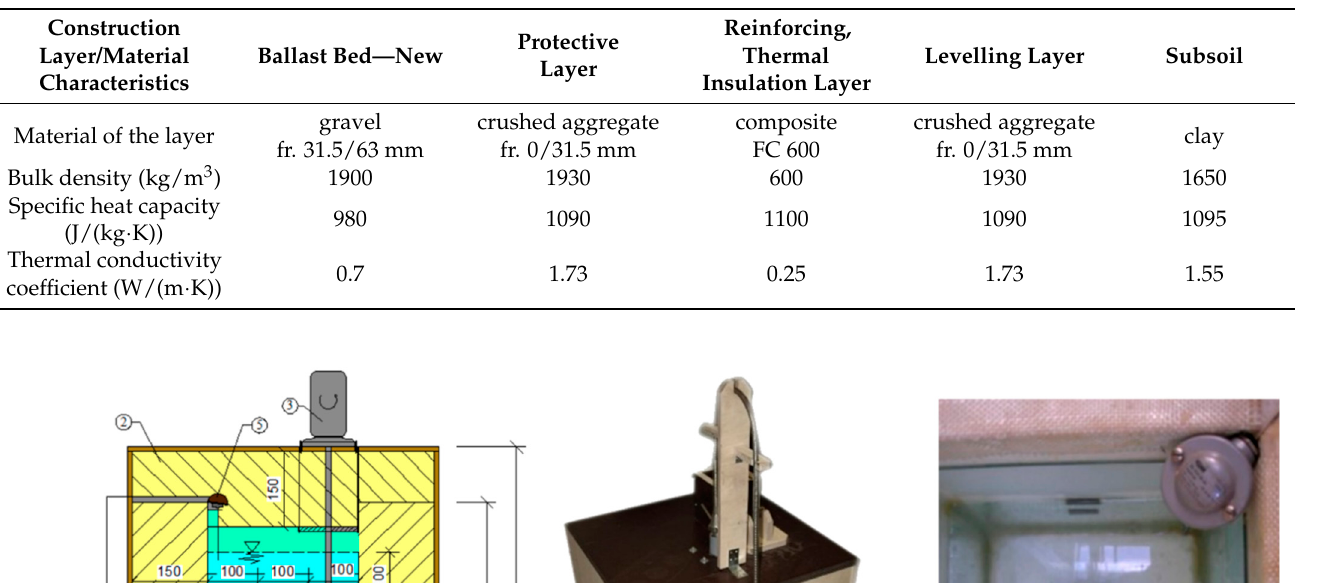
Table 2. Properties of material layers and subsoil.